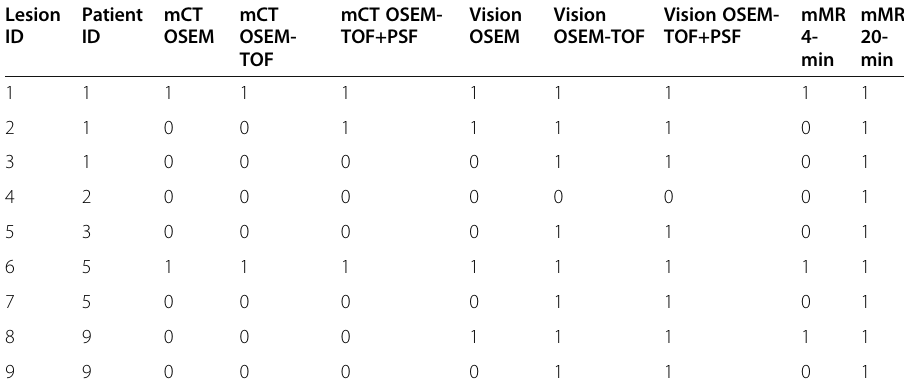
Table 2 Lesion-based detection efficacy analysis